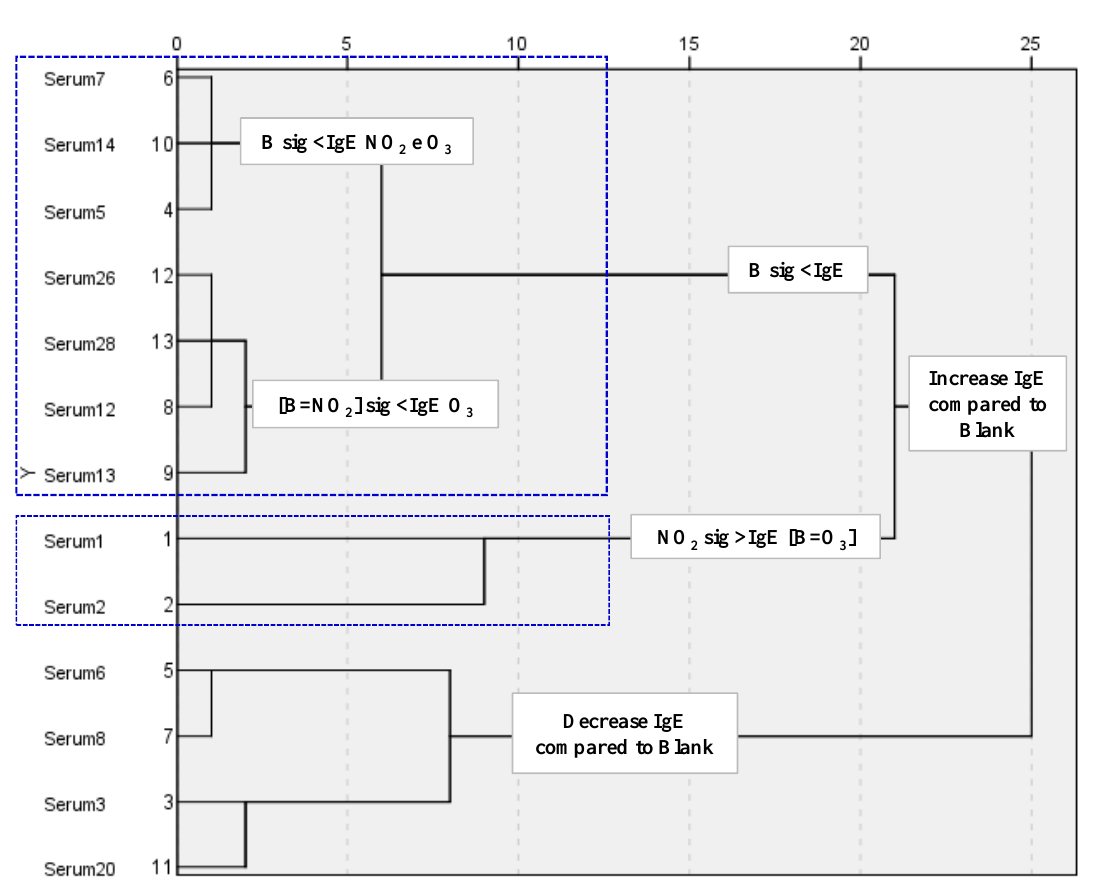
Figure 4. Hierarchical cluster analysis of the results from the indirect ELISA to categorise the different tested sera based on the statistical significance of their quantitative differences (number of clusters determined using the squared Euclidean distance as a distance measure and the nearest neighbour method as a linking method). Two groups of sera were formed based on an IgE increase compared to the blank sample (B) (1, 2, 5, 7, 14, 12, 13, 26, and 28 samples sera) and IgE decrease compared to the blank (3, 6, 8, and 20 samples sera), sig: significative.